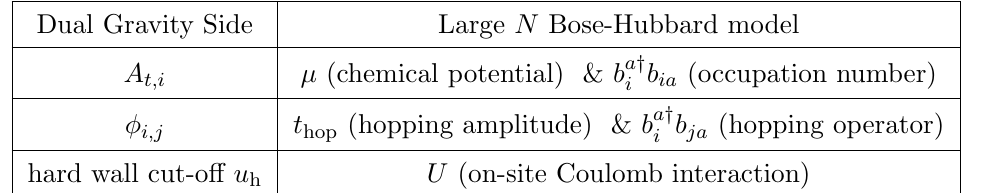
Table 1 . The AdS/CFT dictionary of [4].